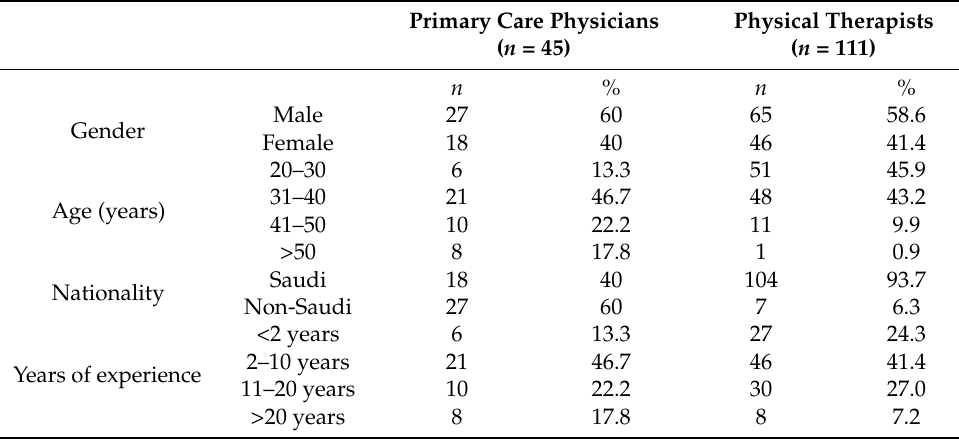
Table 1. Personal and professional characteristics of the 156 participants.